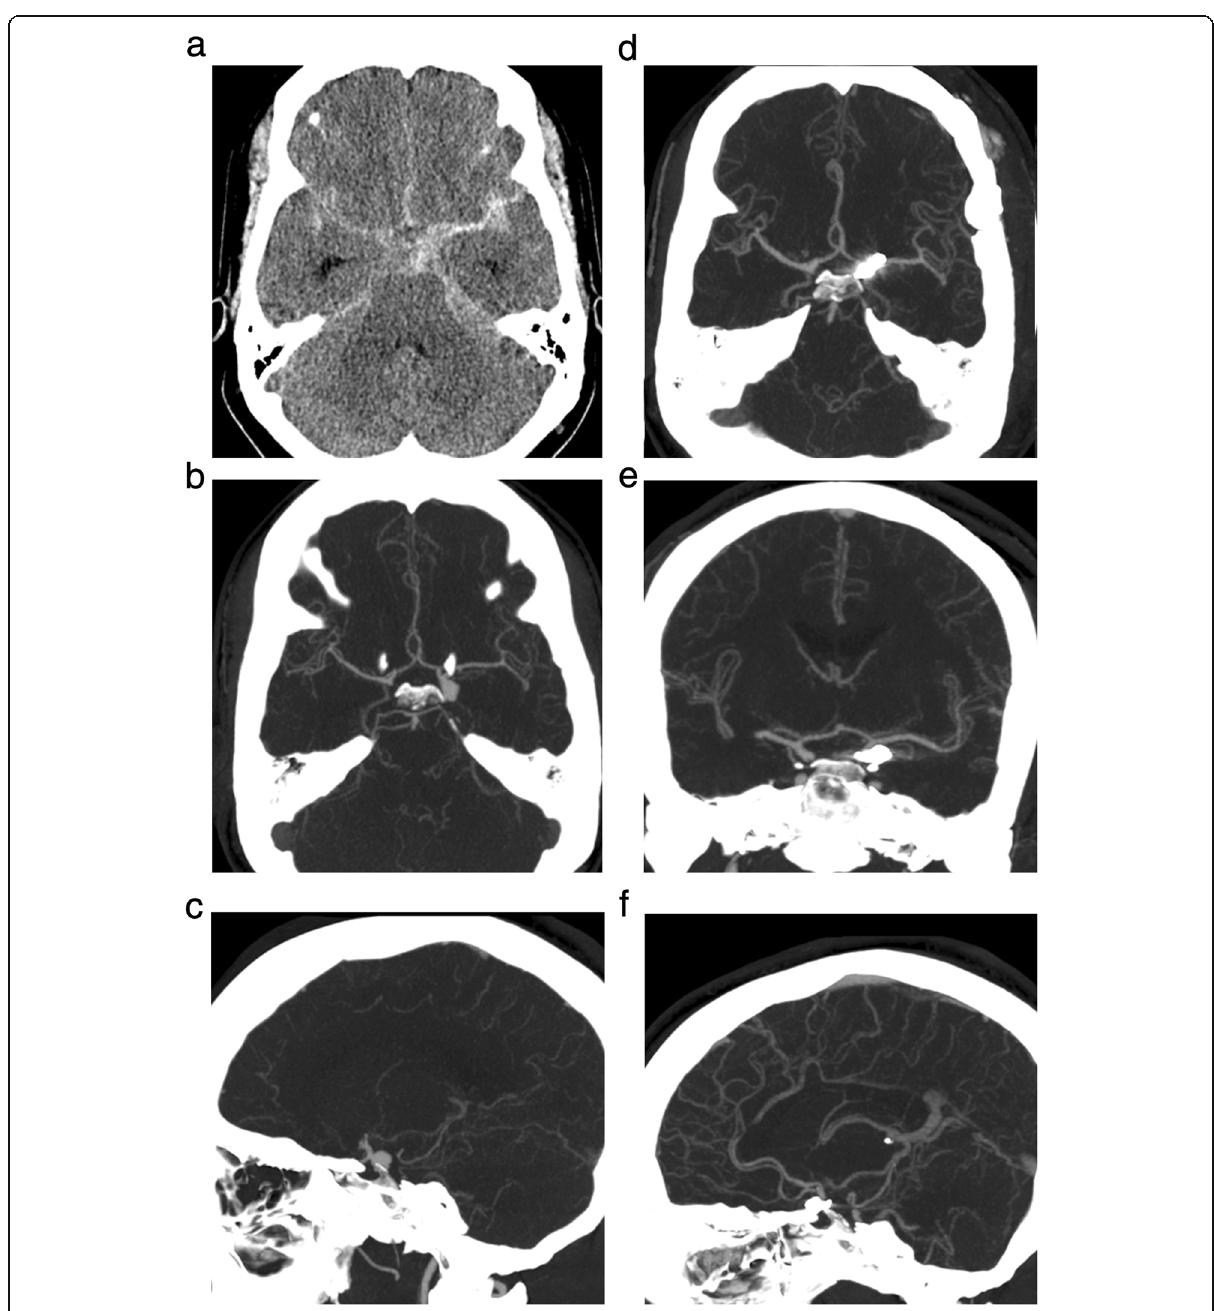
Fig. 2 A case of ruptured Pcom aneurysm successfully clipped through left-side supraorbital approach. Preoperative axial CT scan shows the SAH ( a ). Preoperative axial ( b ) and sagittal ( c ) CTA views show the ruptured Pcom aneurysm on the left side. Postoperative axial ( d ), coronal ( e ), and sagittal ( f ) CTA show clipping of the